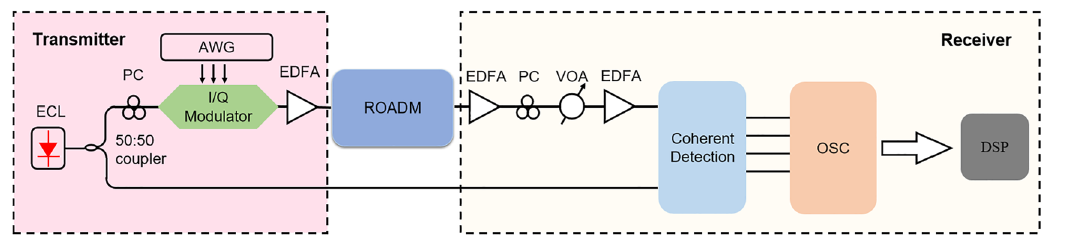
Figure 13: Experiment setup for the system transmission characterization with an external cavity laser (ECL), a 3-dB coupler, two polarization controllers (PCs), an arbitrary waveform generator (AWG), an I/Q modulator (Mod.), three erbium-doped fiber amplifiers (EDFA), a variable optical attenuator (VOA), a coherent detection receiver, an oscilloscope (OSC), and an offline digital signal processor (DSP).